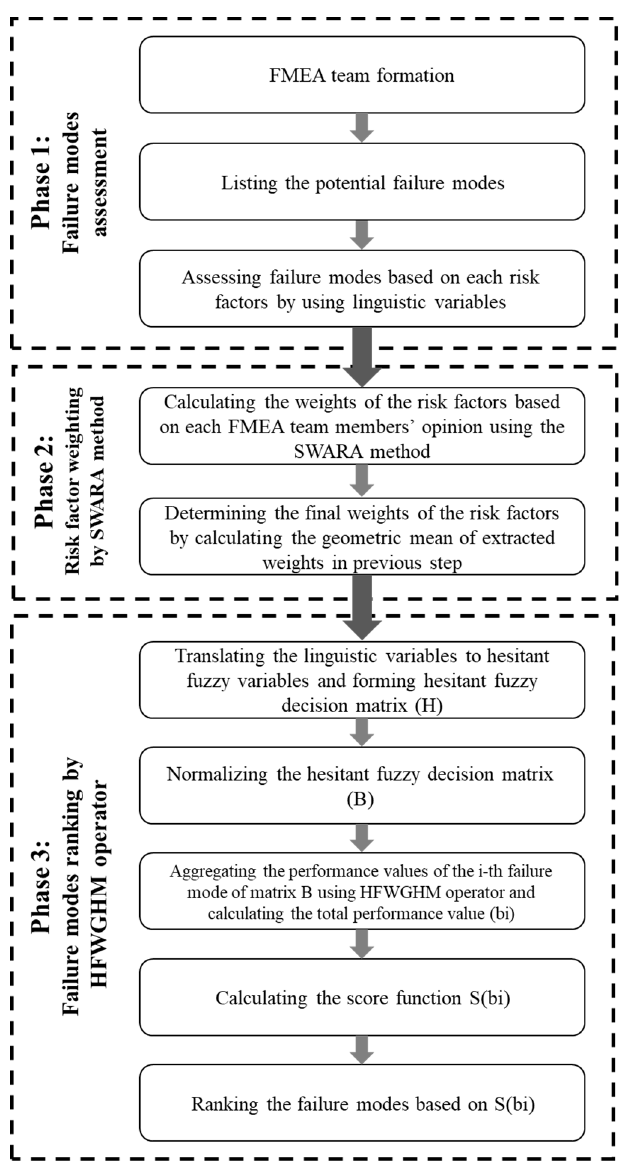
Figure 1. Framework of the proposed FMEA.